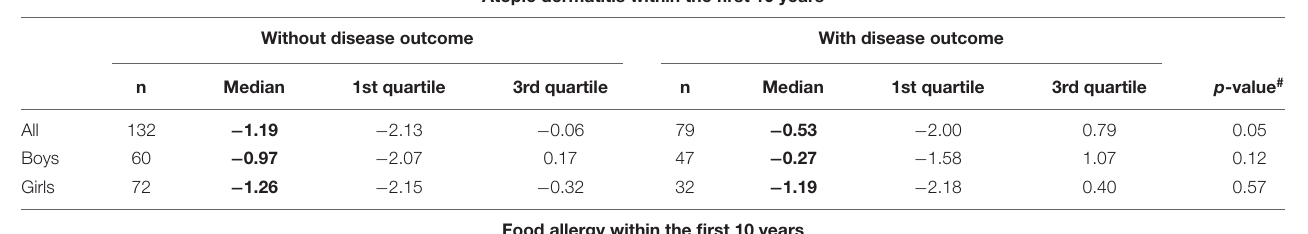
Atopic dermatitis within the first 10 years